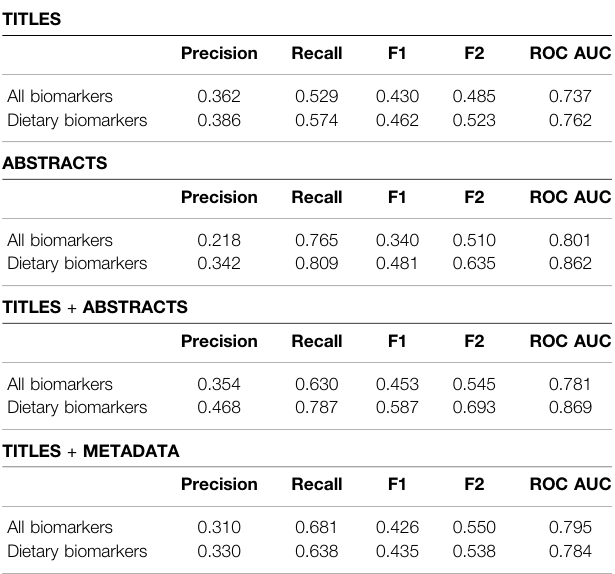
TABLE6| Comparisonofprecision,recallandF-scorebetweenthewholedataset and the restricted